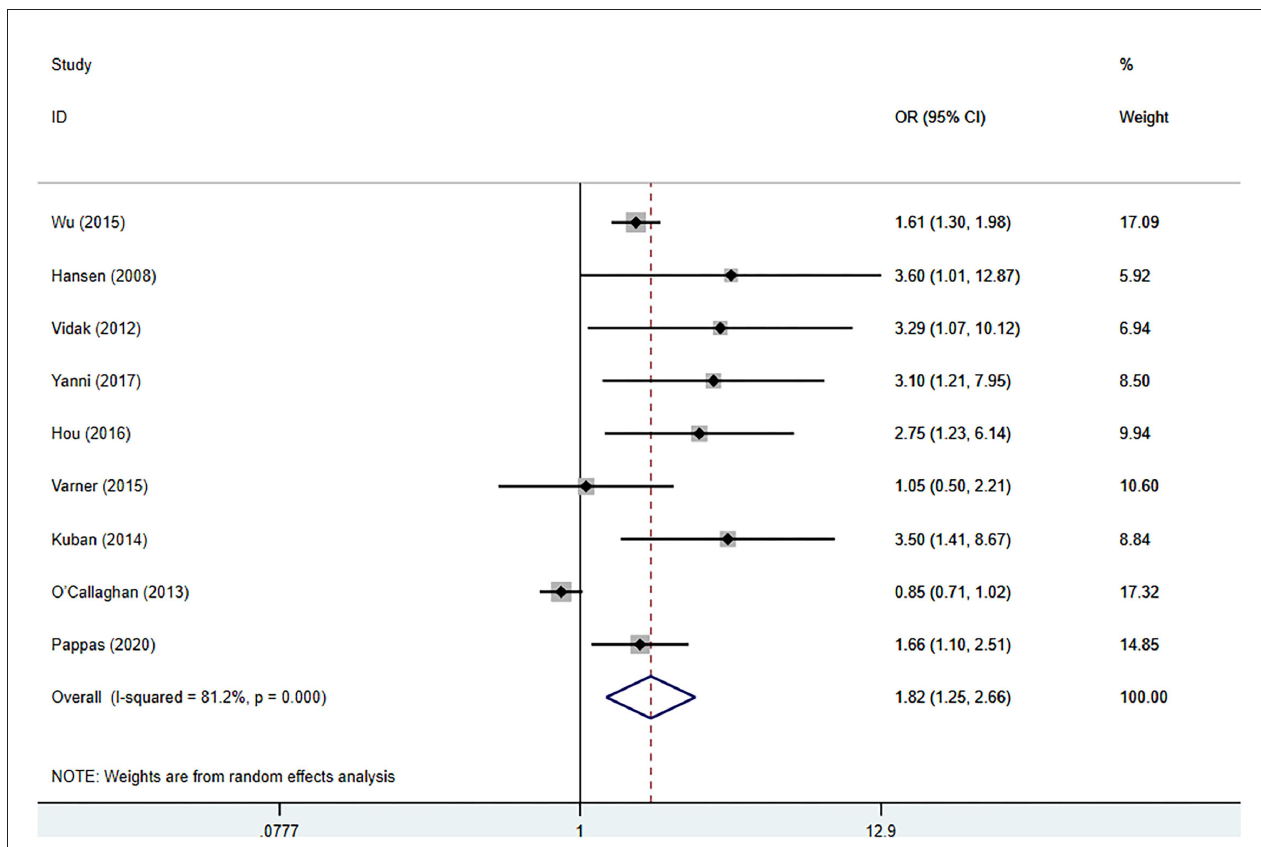
FIGURE 2 | Forest plot of the association between the blood levels of TNF- α and cerebral palsy based on the OR. Weights are obtained from random effects analysis. CI, confidence interval.